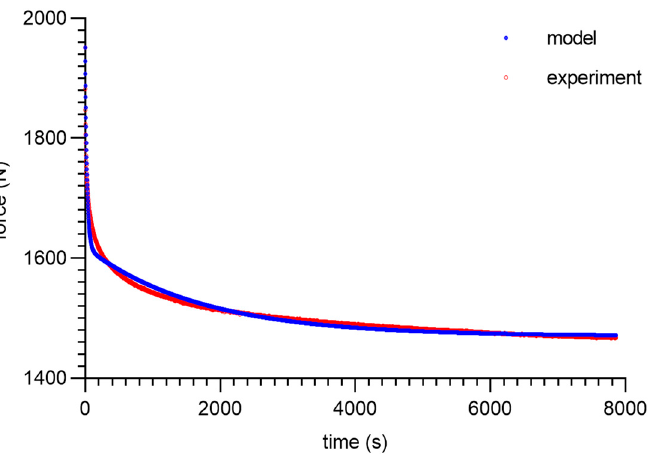
Figure 12. Material 90 ShA— fi ve-parameter relaxation model and experimental data for ε = 25% .